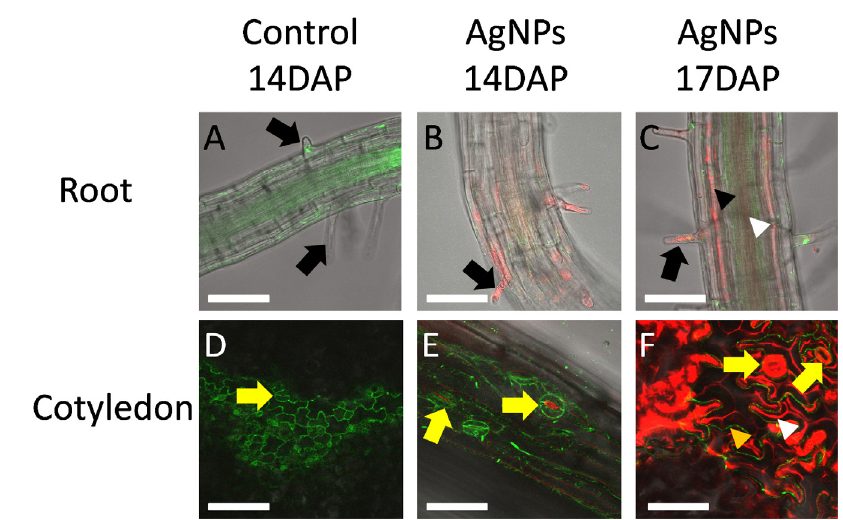
Figure 3. Transport of AgNPs in Arabidopsis ER::GFP plants. Seedlings of 14 ( B , E ) and 17 ( A , C , D , F ) days after planting (DAP) were examined under a Zeiss LSM 510 confocal microscope. ( A , C ) came from root sections of maturation region; ( D – F ) came from cotyledon. ( A ) and ( D ) are control; ( B , C ) and ( E , F ) are AgNPs-treated. Green color was intrinsic GFP; red color was Ag 0 light scattering. At 14 DAP, AgNPs accumulated mainly in root hair cells and surface of roots ( B ). By 17 DAP, AgNPs already entered vascular tissue, both phloem (white arrowhead) and xylem (black arrowhead), of the roots and could be bulk transported through vascular tissue. Upon germination, some condensed media might have touched cotyledons. At 14 DAP, AgNPs could be observed in the pores of stomata (yellow arrows in E ). By 17 DAP, not only the pores of stomata but also the stomata themselves (yellow arrows in F ) showed AgNP accumulation. The uneven surface of pavement cells [56] showed AgNP accumulated on the grooves (white arrowhead) between pavement cells (orange arrow). Scale bar = 0.2 μ